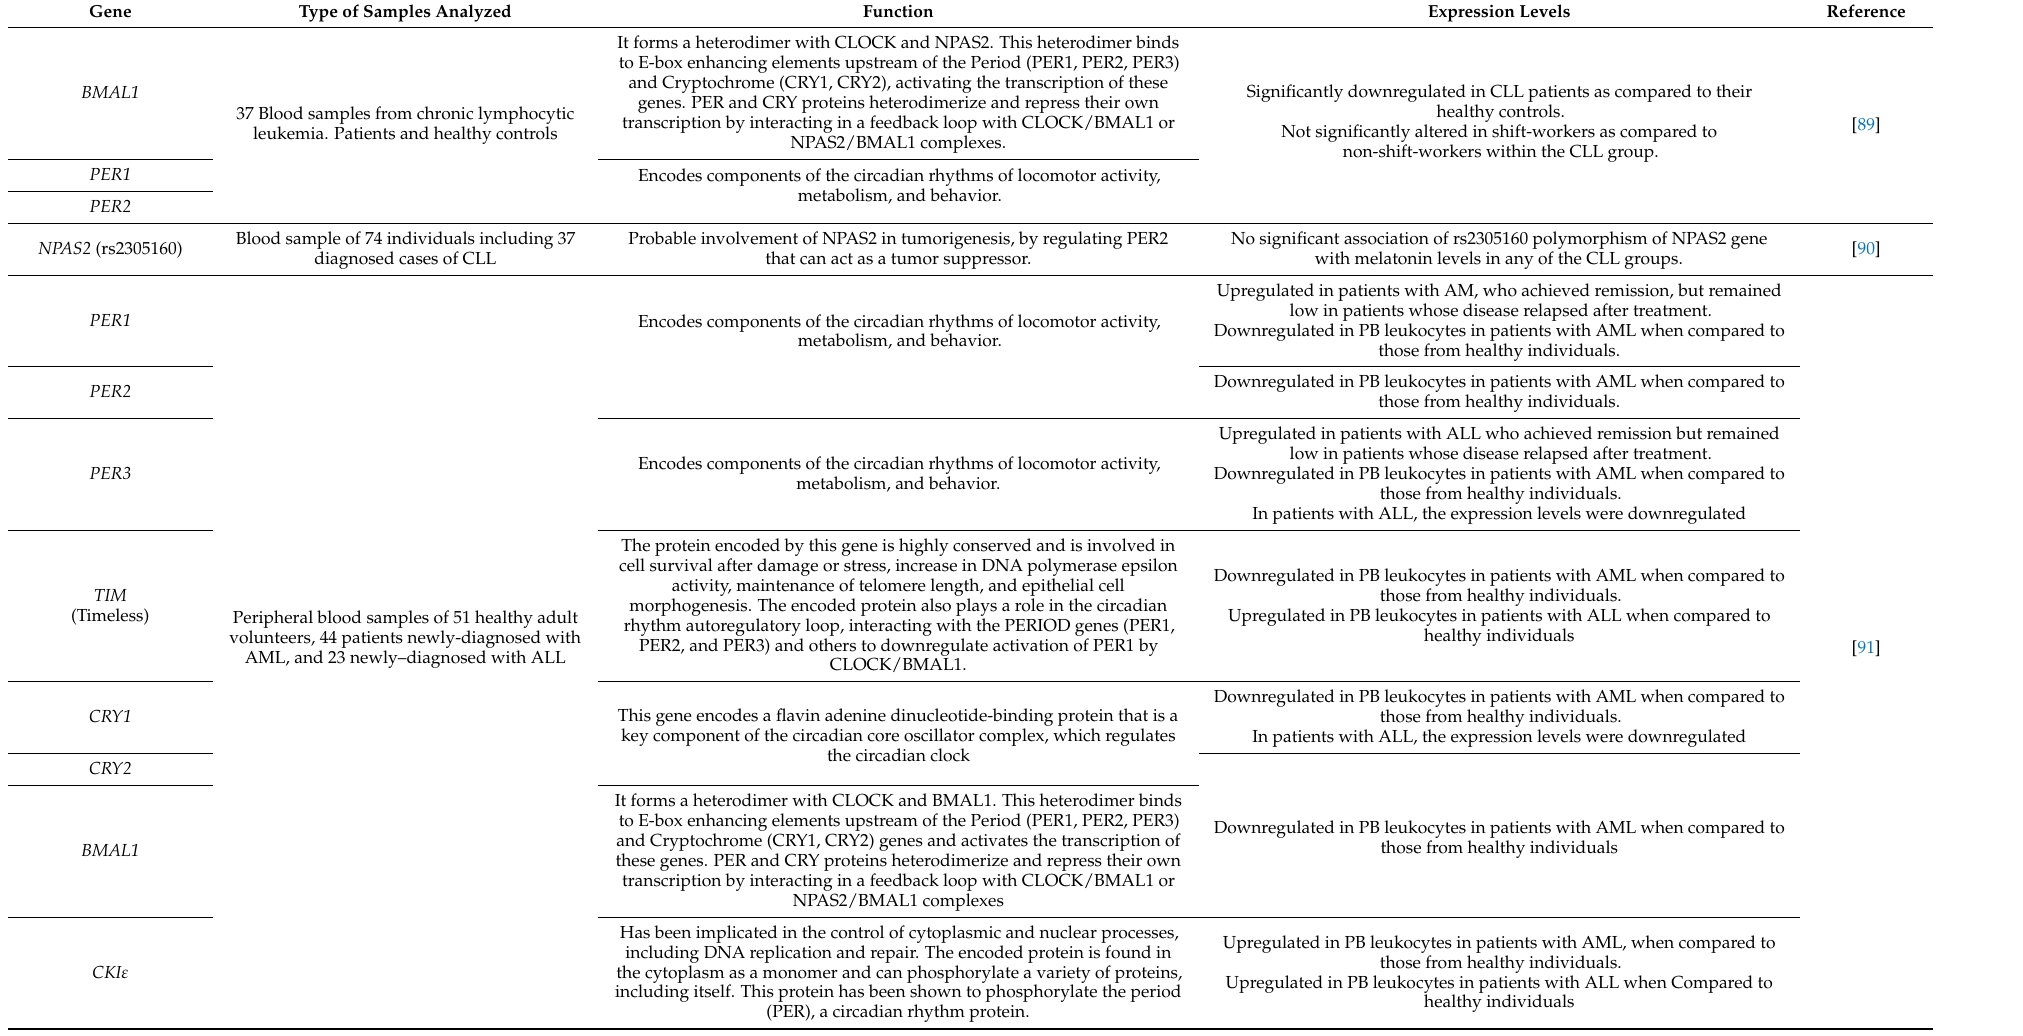
Table 1. Studies on the involvement of clock genes in leukemia pathogenesis, from the past 10